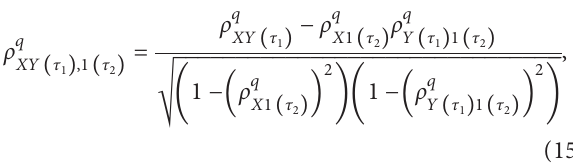
Figure 4: The multifractal spectra f obtained through MFDPXA, where x , y , and z denote the SSEC, SZI, and